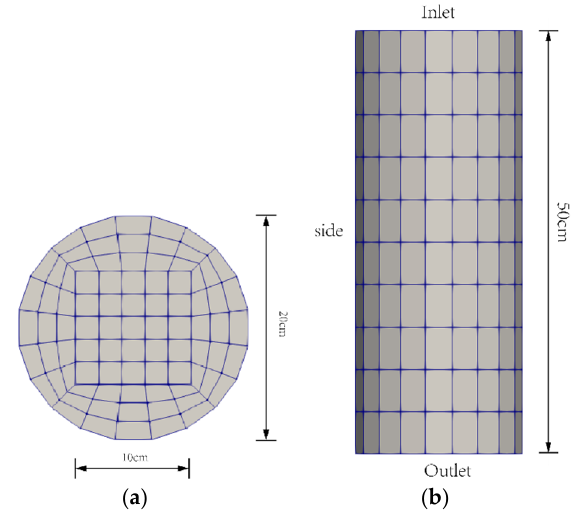
Figure 4. The CFD mesh: ( a ) top view, ( b ) side view.